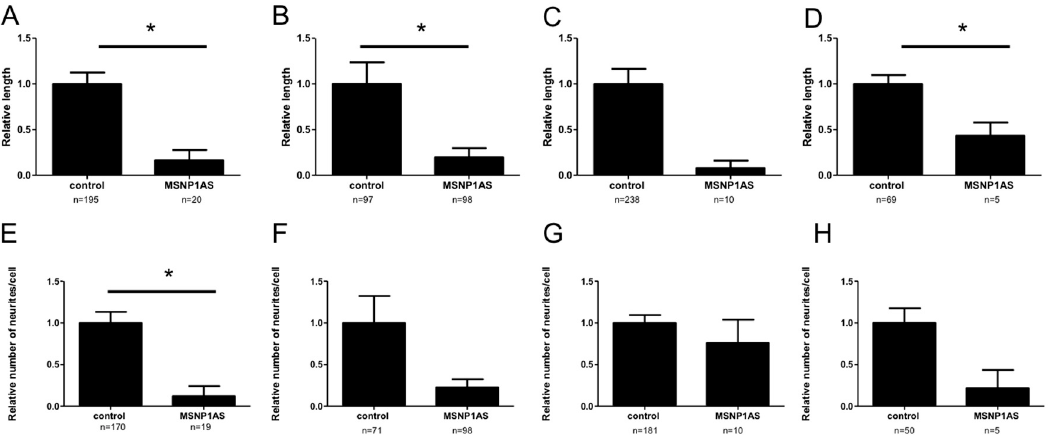
Figure 2. Overexpression of MSNP1AS decreases neurite number and length. SK ‐ N ‐ SH cells that overexpressed MSNP1AS had decreased neurite length after ( A ) 24 h and ( B ) 72 h. ReNcell CX cells that overexpressed MSNP1AS also had decreased neurite length after ( D ) 72 h but the decreased neurite length after ( C ) 24 h was not significant. SK ‐ N ‐ SH cells that overexpressed MSNP1AS had fewer neurites per cell after ( E ) 24 h and a trend toward reduced neurites per cell after ( F ) 72 h. ReNcell CX cells that overexpressed MSNP1AS also had trend toward fewer neurites per cell after ( H ) 72 h, but the neurite number decrease after ( G ) 24 h was not significant (* p < 0.05, Mann ‐ Whitney U test).